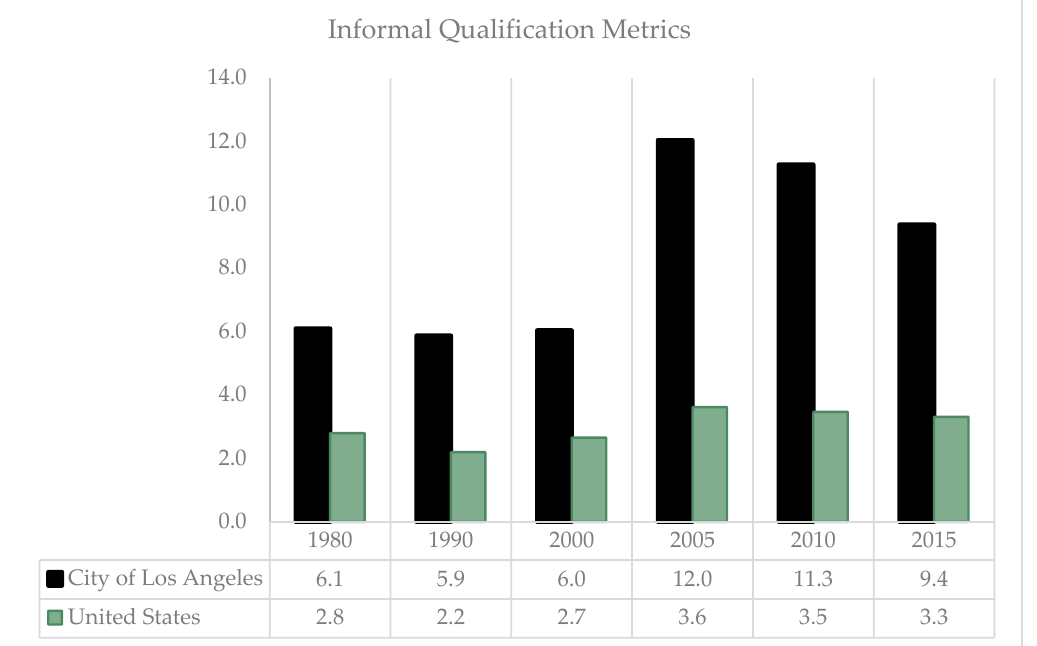
Figure 1. The informal qualification metrics for the city of Los Angeles and the United States, 1980–2015. The metrics are derived by dividing a location’s median home value by the location’s median household income. These metrics determine whether a household can afford to purchase a home, with metrics below 2.7 considered affordable. Source. U.S. Census Bureau.